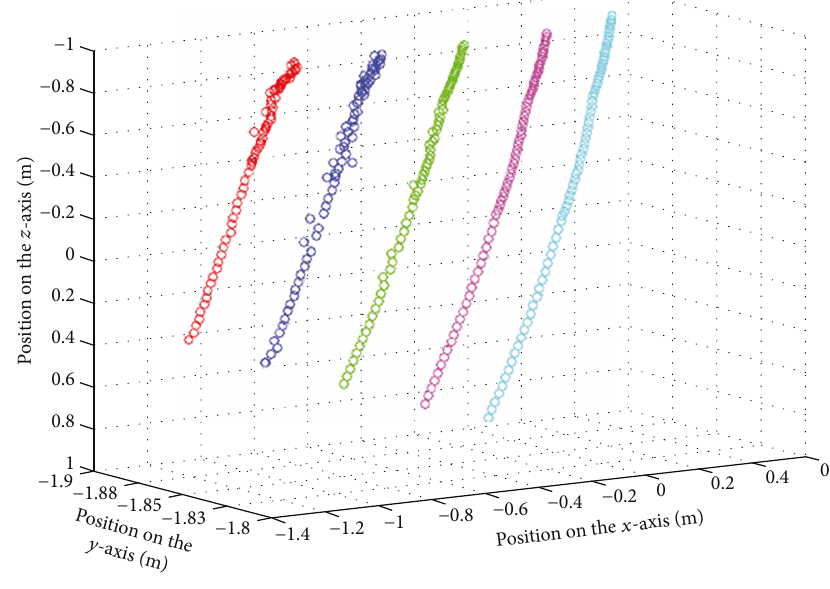
Figure 34: 3D chart for analysis of a test point.